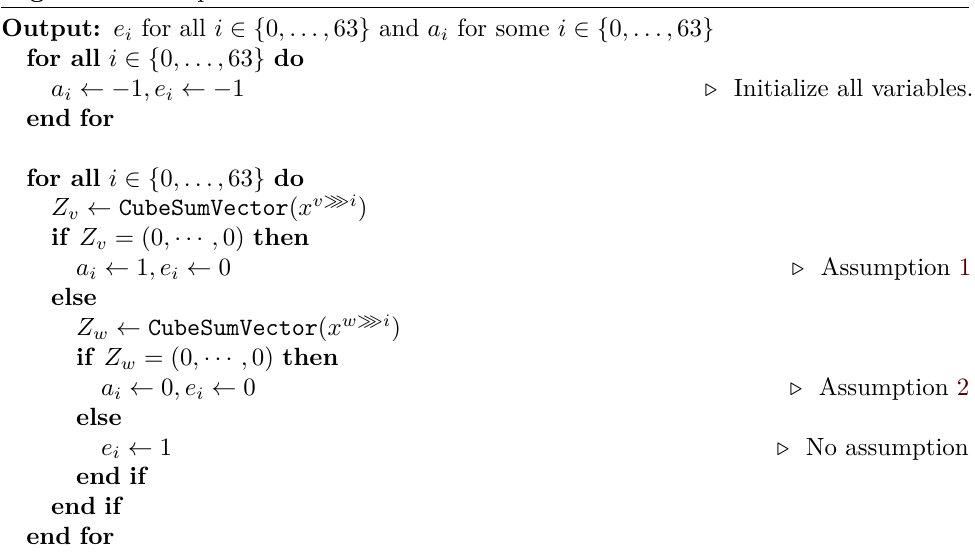
Algorithm 1 Step 1: v and w are defined in Table